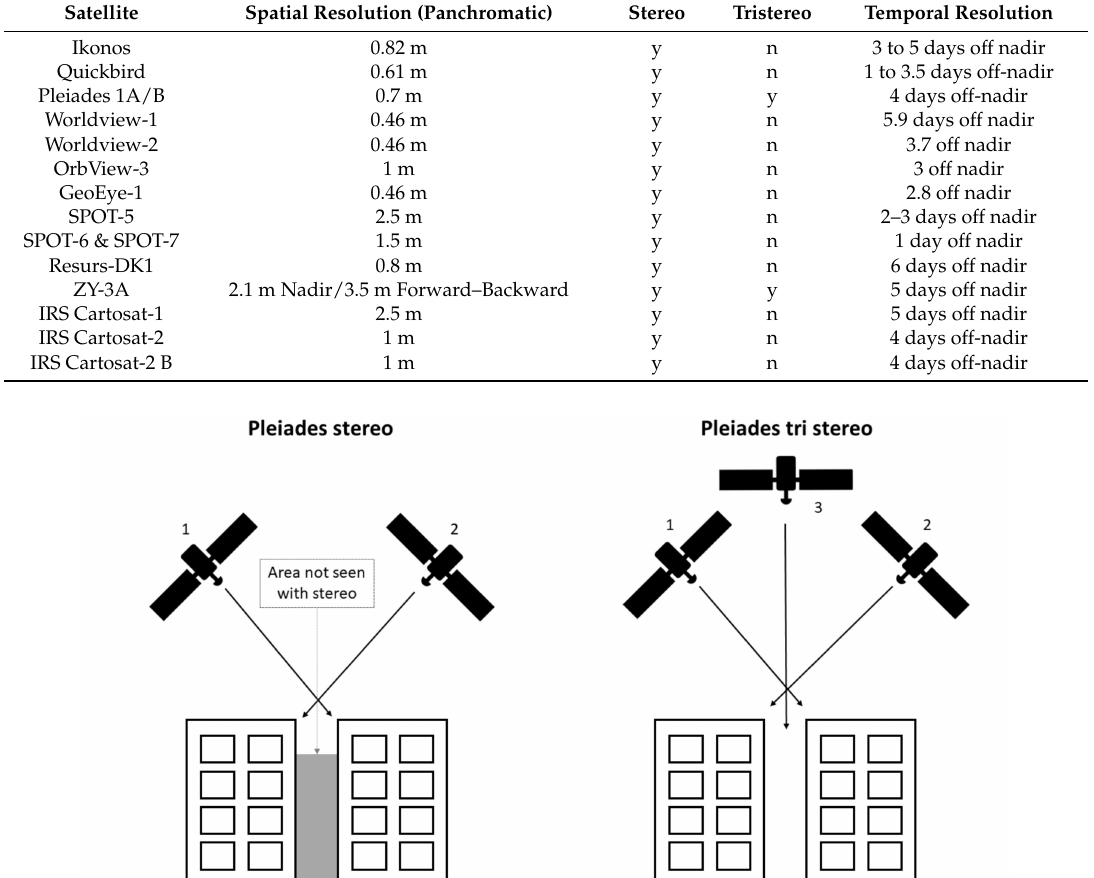
Figure 1. Stereo and tri-stereo views of the Pleiades-1